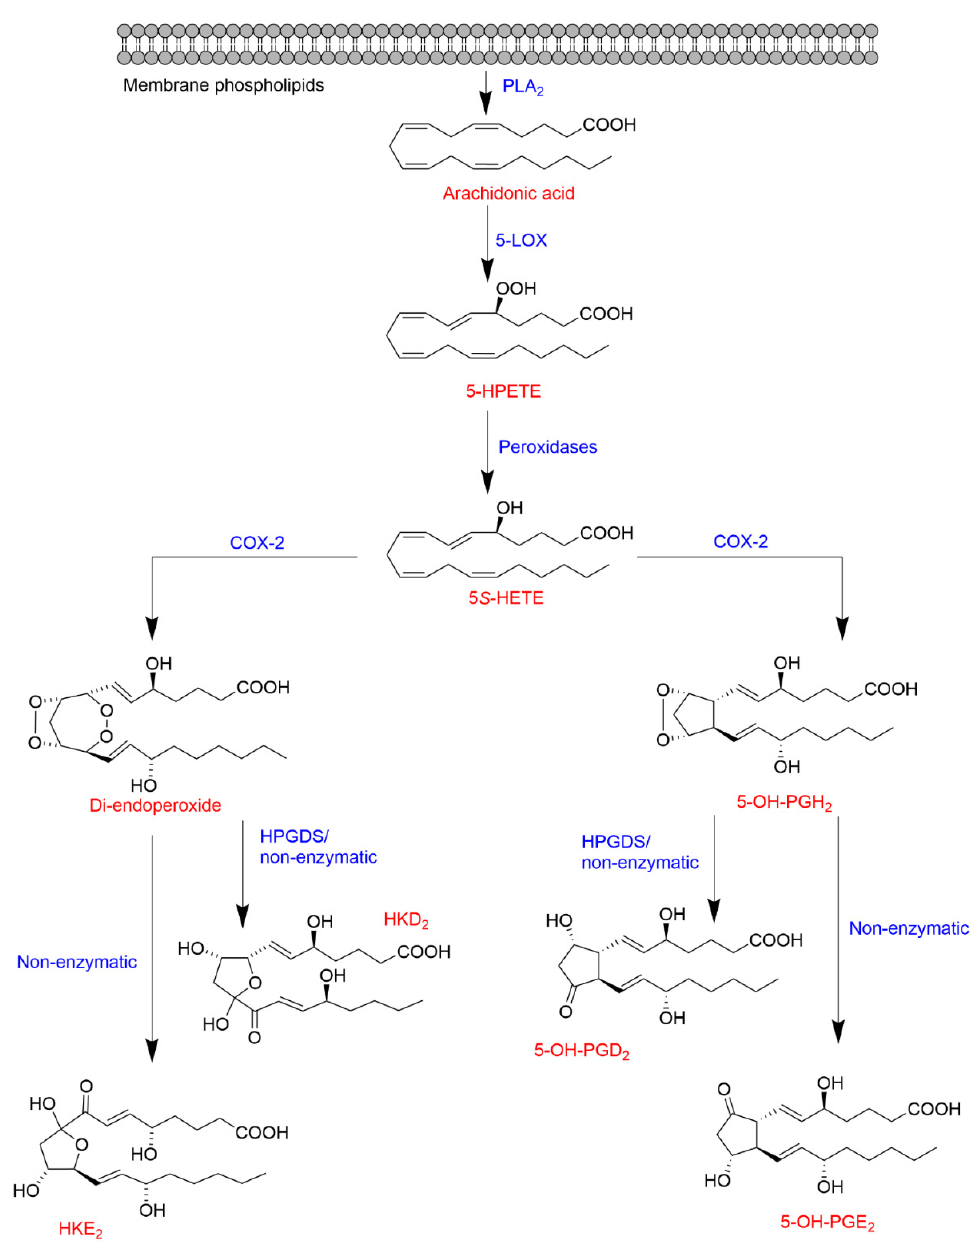
Figure 3. Biosynthetic crossover of the 5-LOX and COX-2 pathways yielding hemiketal eicosanoids and